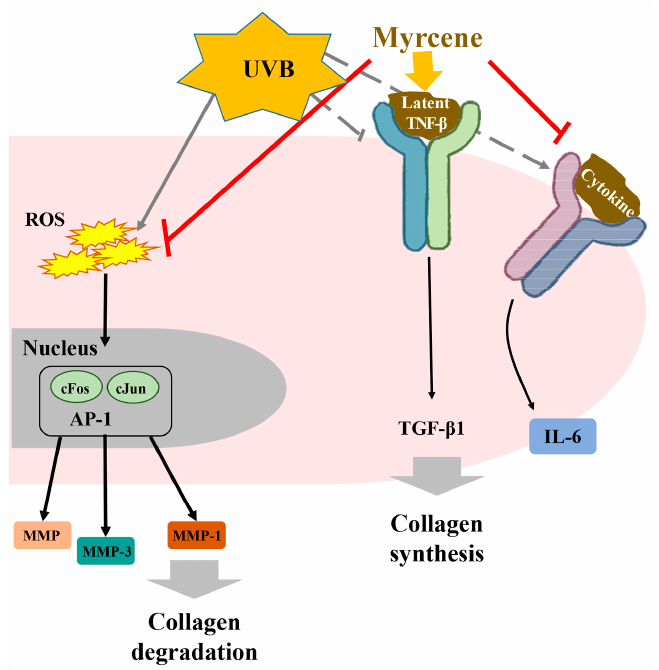
Figure 8. Myrcene effectively controls UVB-radiated skin aging through MMPs and IL-6 downregulation and collagen synthesis through TGF- β upregulation (Modified from Hwang 2017 [80]). Myrcene not only blocks collagen degradation by protecting UVB-induced ROS but also stimulates collagen synthesis through TGF- β 1 activation. UVB-induced ROS finally induces collagen degradation, which is caused by MMP-1, MMP-3, and MMP-9 that are made by transcription factors such as AP-1, cFos, and cJun. UVB radiation inhibits TGF- β 1 activation, which stimulates collagen synthesis. : to inhibit the follow action.